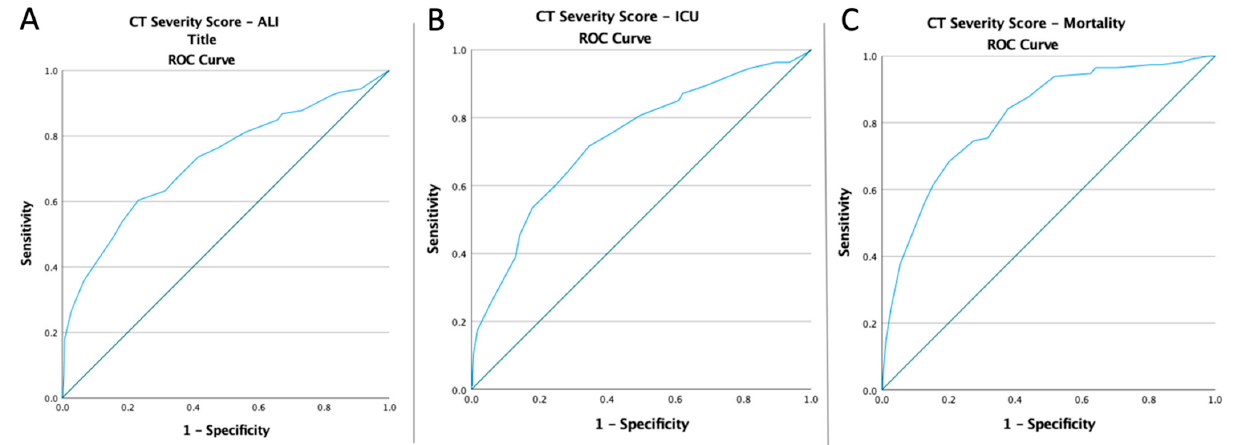
Figure 3. ROC curve analysis concerning the mortality ( A ) MLR (AUC: 0.829; p < 0.0001), ( B ) NLR (AUC: 0.856; p < 0.0001), ( C ) SII (AUC: 0.858; p < 0.0001), ( D ) SIRI (AUC: 0.785; p < 0.0001), ( E ) AISI (AUC: 0.765; p < 0.0001), and ( F ) TSS (AUC: 0.759; p < 0.0001).